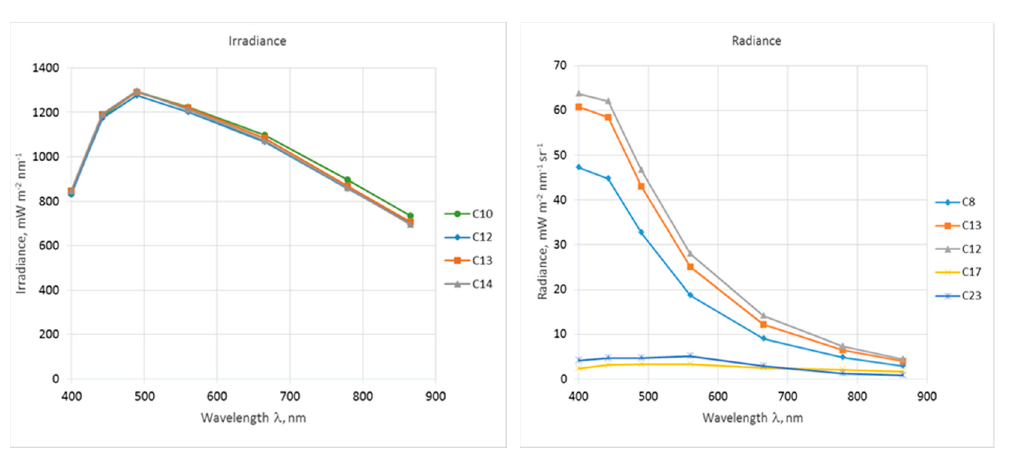
Figure 9. Irradiance and radiance consensus values in the outdoor experiment. C8, C10, C12, C13, C14—blue sky ( radiance ) or direct sunshine ( irradiance ); C17—water in cloud shadow; C23—sunlit water.